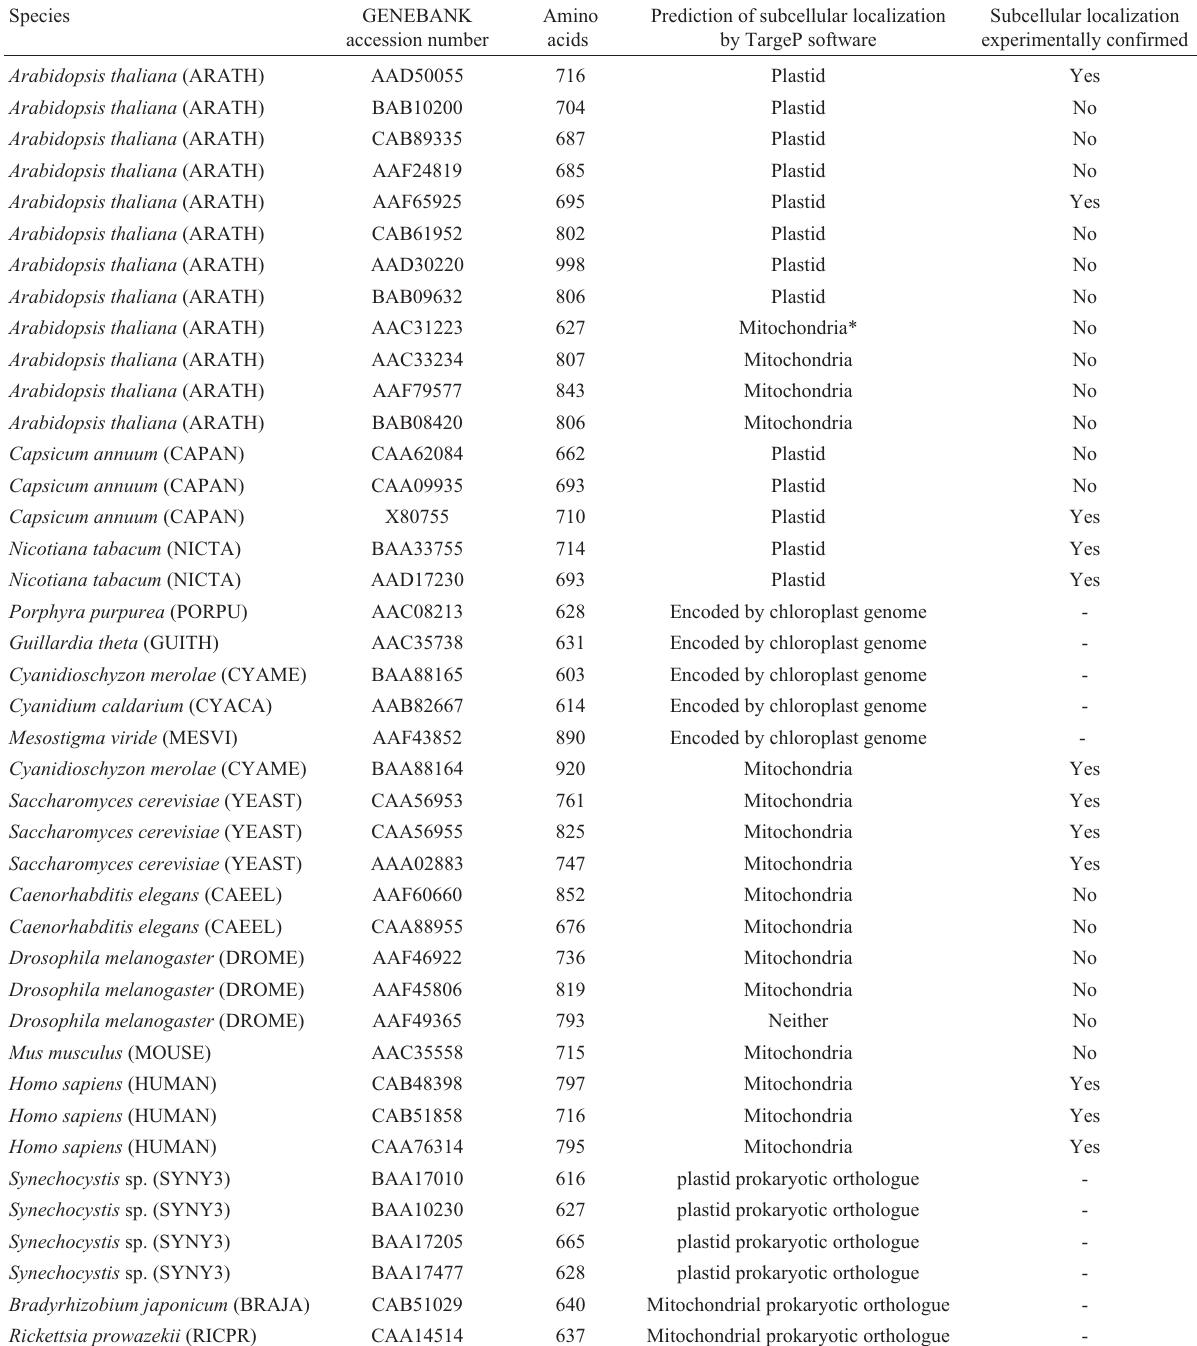
Table I - List of the protein sequences used on phylogenetic